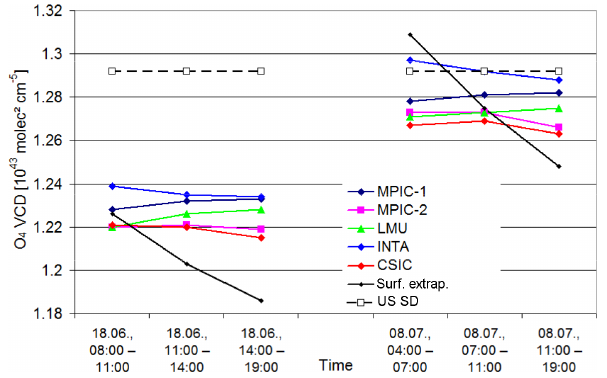
Figure 7. Comparison of the O 4 VCDs for the selected periods on both days calculated from the profiles extracted by the differ- ent groups. Also, the results for the profiles extrapolated from the surface values and the US standard atmosphere are